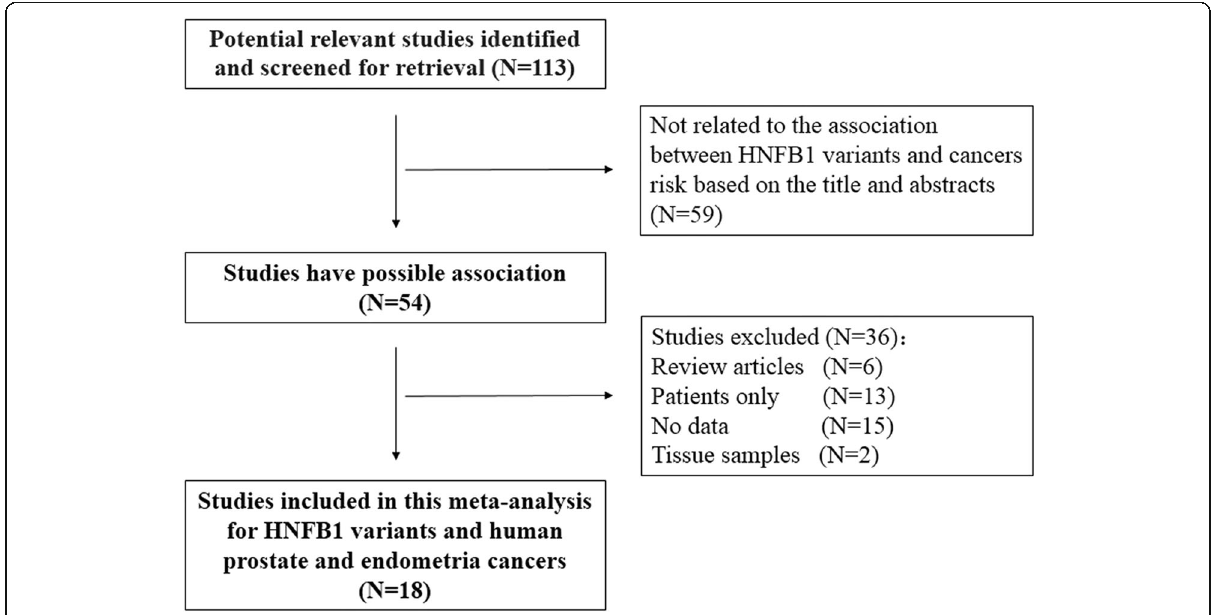
Fig. 1 Flow diagram of included and excluded